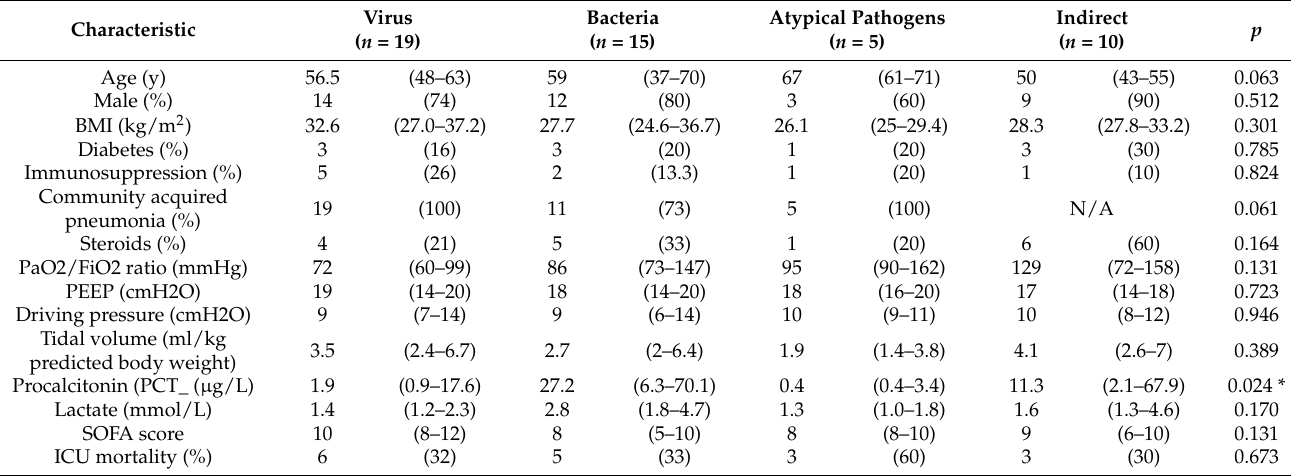
Table 1. Characteristics of patients with acute respiratory distress syndrome (ARDS) caused by viral, bacterial or atypical pathogen pneumonia and indirect